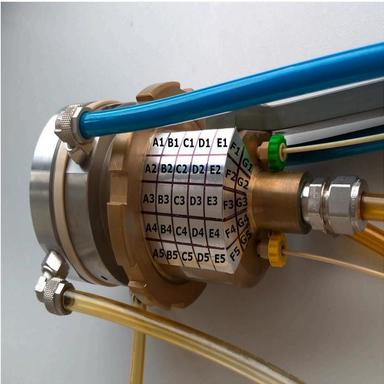
Marking of the position of activation foil placed on the water target.